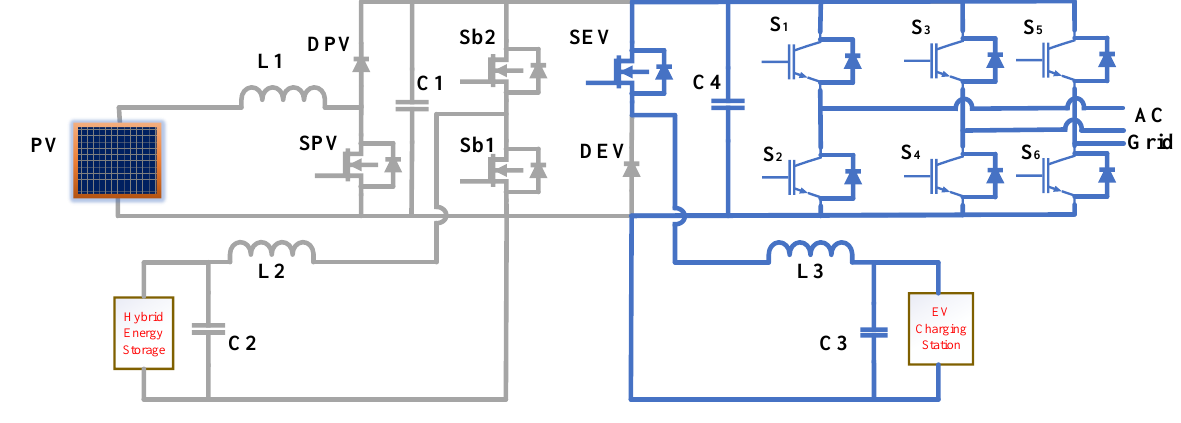
Figure 9. Power flow from Grid to EV Charging station.